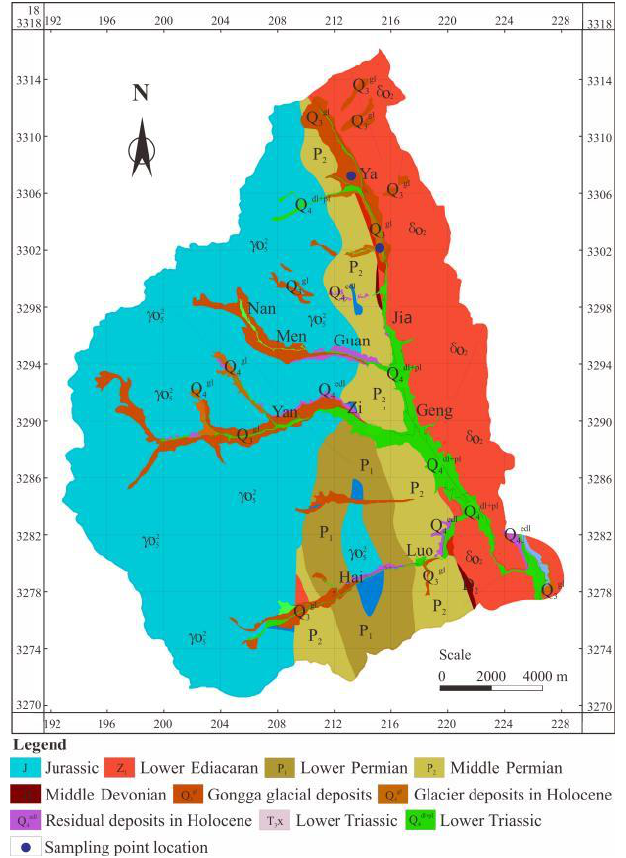
Figure 2. Geological map of the study area and location map of sampling points.